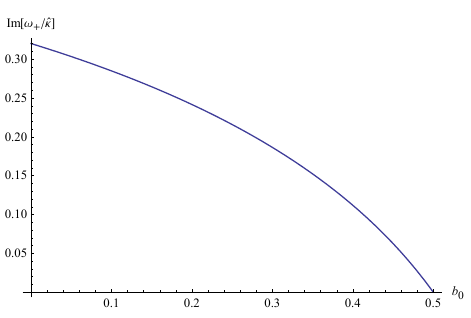
] of the charged black ring on the electric charge with ‘ = 0, +